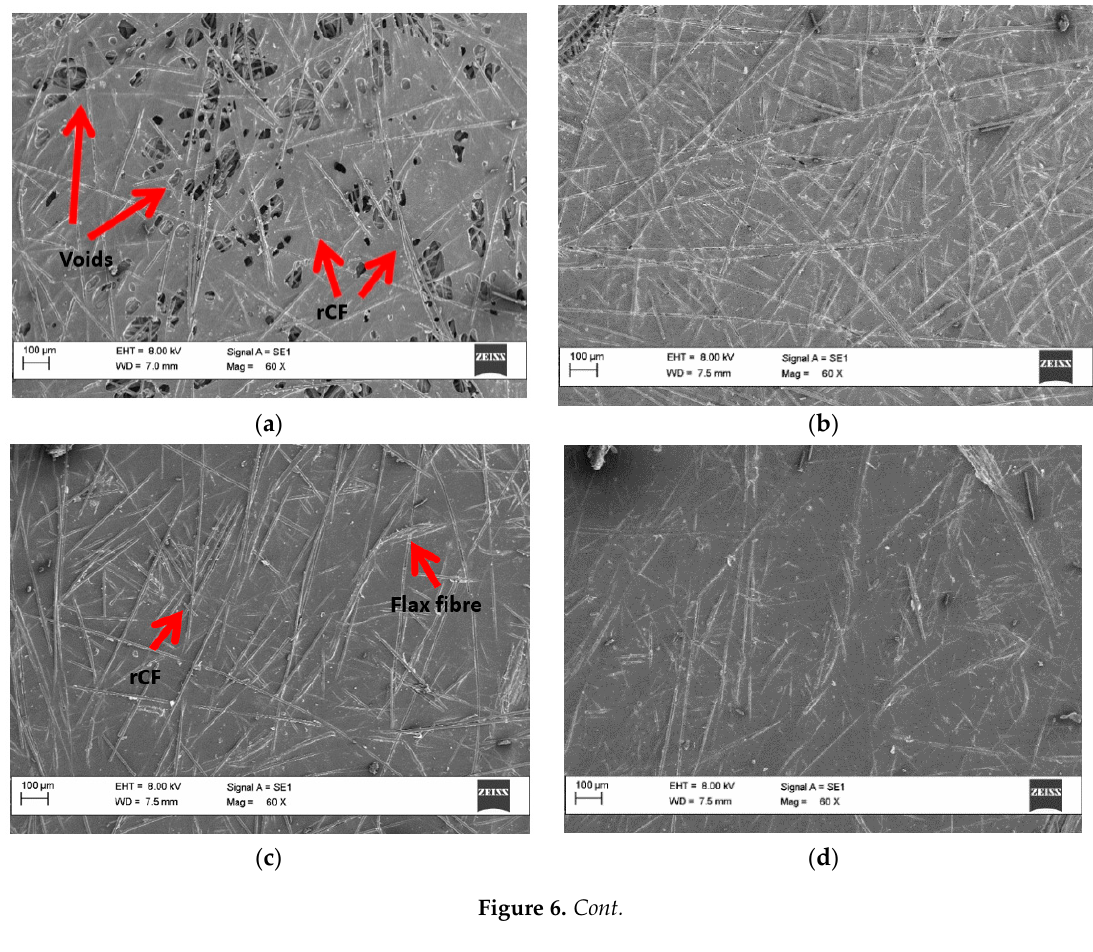
Figure 5. Flexural modulus and strength for all tested samples. Sample 1 showed lower properties due to voids in the